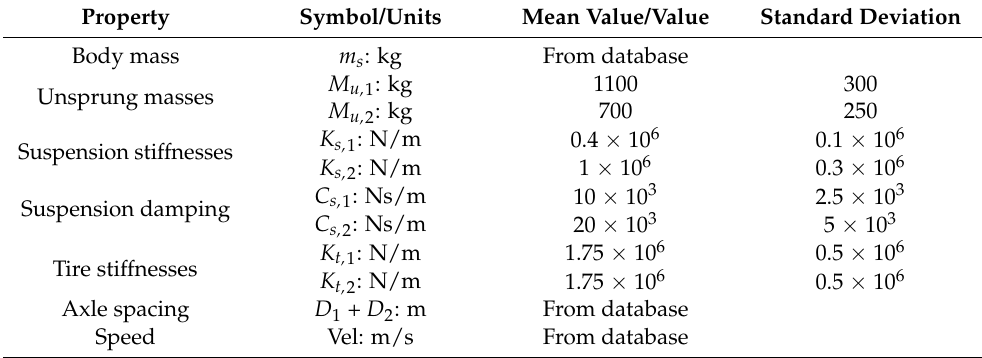
Table 2. Vehicle population properties.